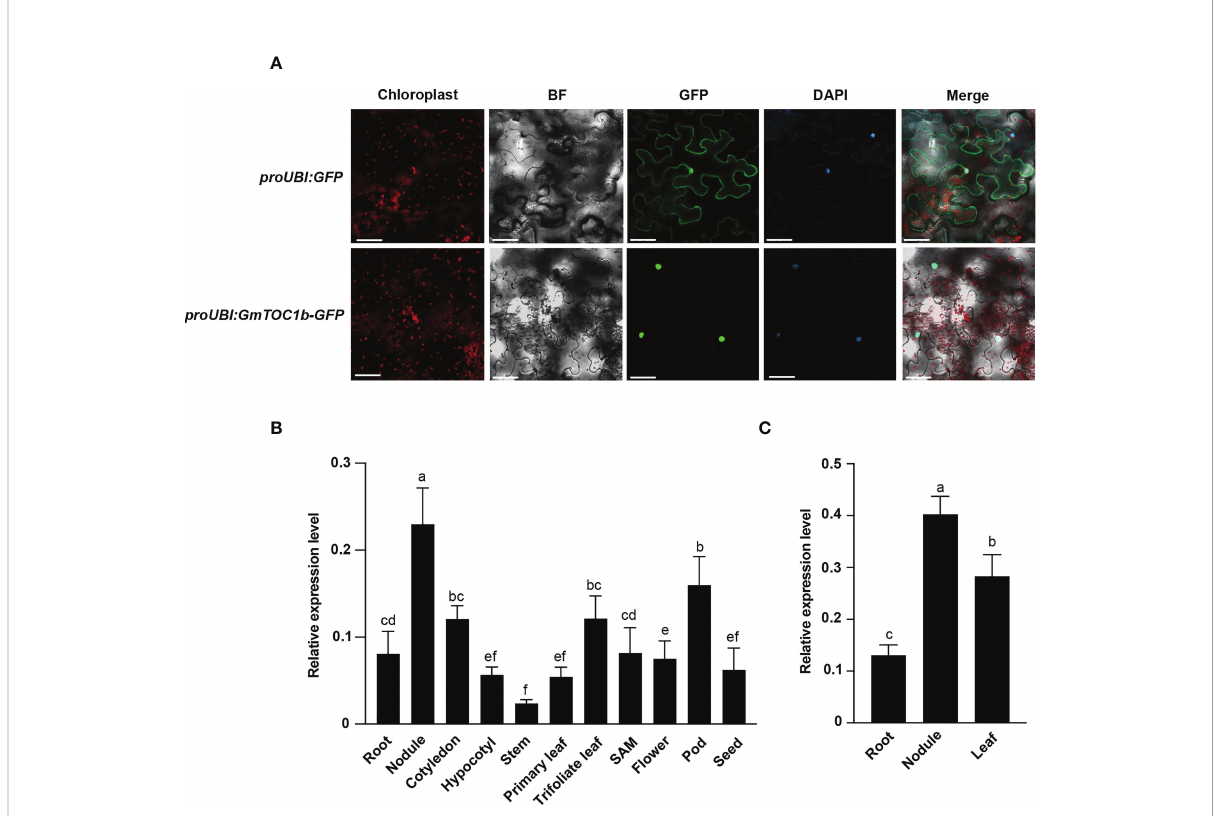
FIGURE 2 GmTOC1b localization and expression pattern analyses of GmTOC1b . (A) Subcellular localization of GmTOC1b. Nicotiana benthamiana leaves were transiently in fi ltrated with proUBI : GFP or proUBI : GmTOC1b-GFP ; the plants were then grown for 48 h under 16-h-light/8-h-dark condition before GFP fl uorescence was observed by microscopy. GFP, green fl uorescent protein; BF, bright fi eld; Merge, GFP and BF images. Scale bars = 20 m m. (B) Relative GmTOC1b transcript levels in various tissues during growth and at different development stages. Relative expression level was calculated as the ratio of the expression value of the target gene to that of reference gene GmActin as an internal standard. (C) RT-qPCR analysis of GmTOC1b in different tissues at 14 days after inoculation (DAI) with rhizobia. Relative expression level was calculated as the ratio of the expression value of the target gene to that of reference gene GmActin as an internal standard. Three biological replicates were performed in all experiments. Different lowercase letters indicate signi fi cant differences as determined by Student ’ s t